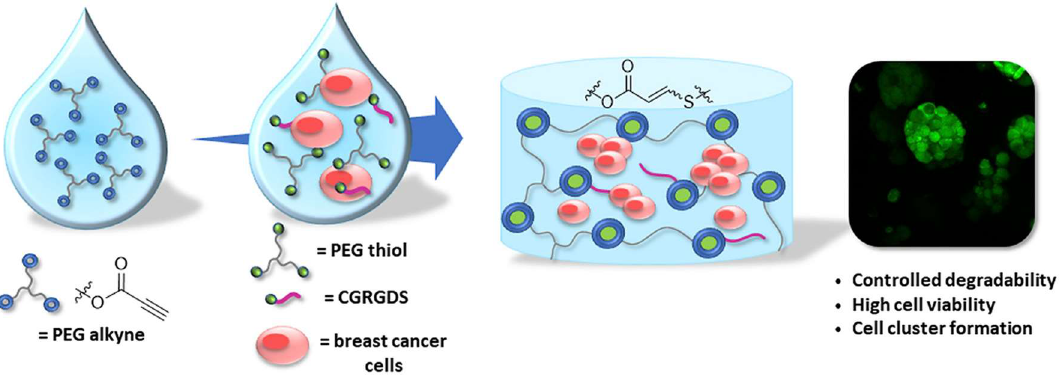
Figure 19. The non-radical nucleophilic addition reaction between multi-armed PEG-thiol and PEG-alkyne produced vinylene sulfide-linked hydrogel for encapsulation of MCF-7 breast cancer cells. An extracellular matrix mimicking peptide CGRGDS is incorporated to the gel through the same type of addition between the thiol group in the cysteine and PEG-alkyne during the network formation. The hydrogel is degradable through hydrolysis of the esters in PEG-alkyne to allow cell growth and formation of cell clusters. Images reproduced with permission from [107]. Copyright 2018 Elsevier.